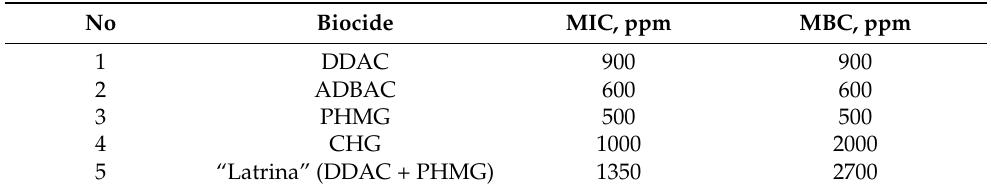
Table 4. MIC and MBC of some individual GACs and guanidine and biguanide derivatives for A. faecalis DOS7 in comparison to biocide “Latrina”.